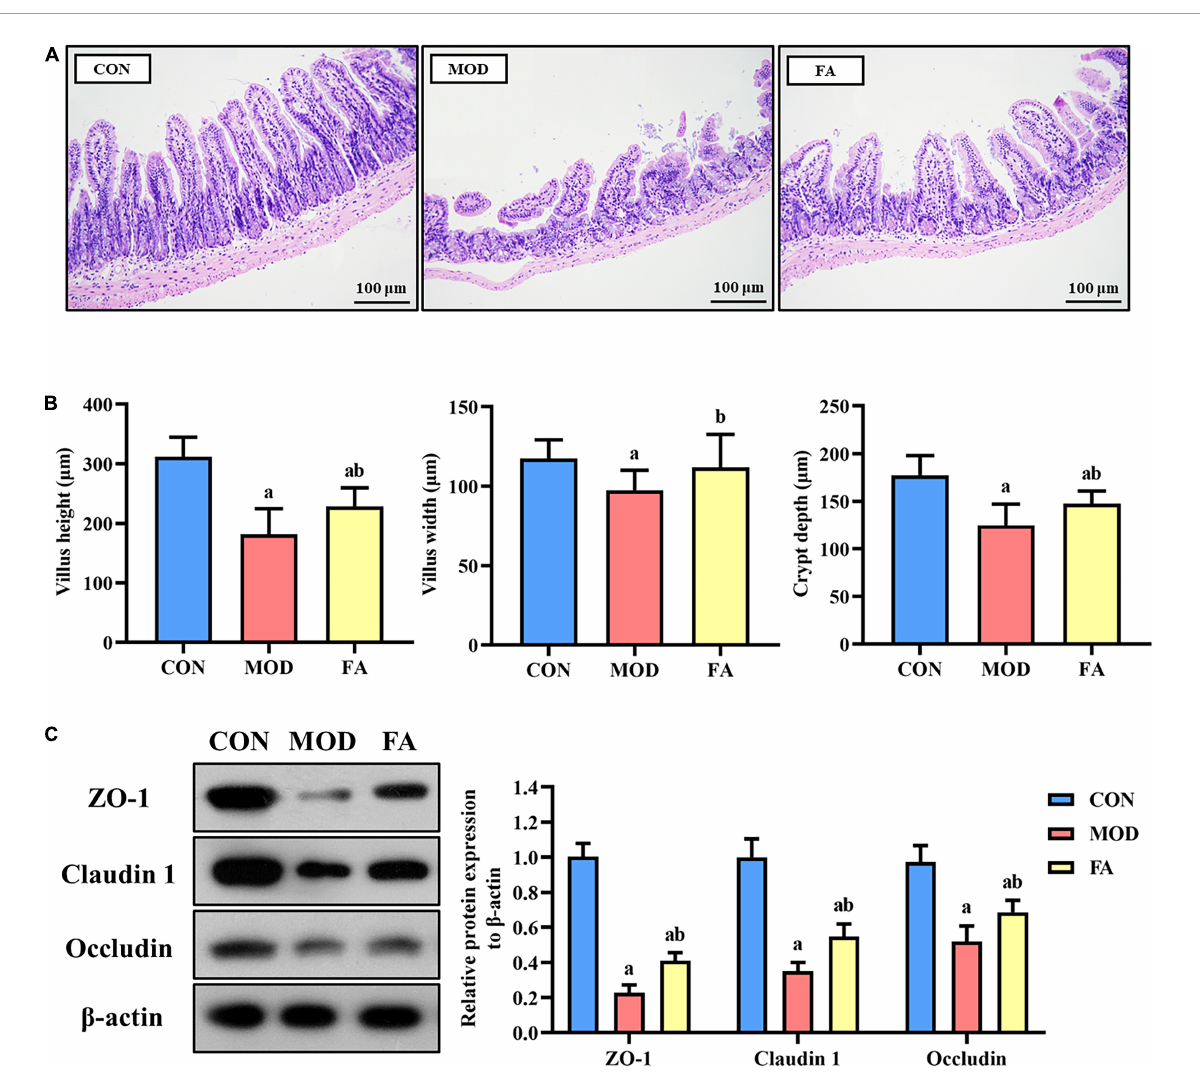
FIGURE3 Effects of folic acid on the ileum and the expression levels of tight junction protein. (A) Ileum histopathology assessed by H&E staining (200 × ); (B) measurement of villus height, height width, and crypt depth; (C) representative Western blot of ZO-1, claudin 1, and occludin protein levels relative to the expression of β -actin in the ileum. Data are presented as mean ± SD ( n = 3/group). a p < 0.05 compared with the CON group; b p < 0.05 compared with the MOD